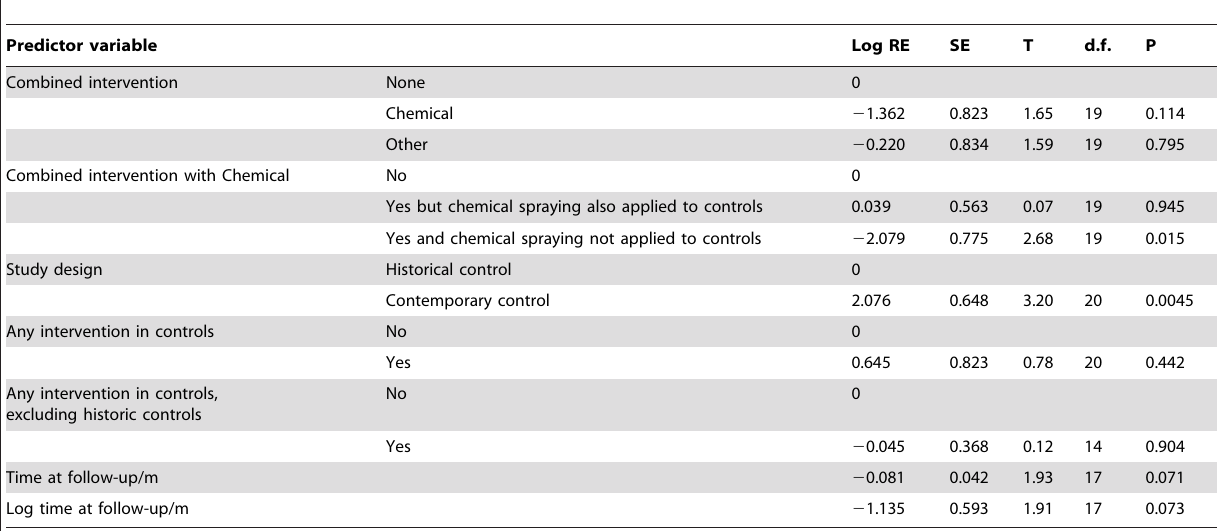
Table 1. Single predictor variable analysis of relative effectiveness (RE) a